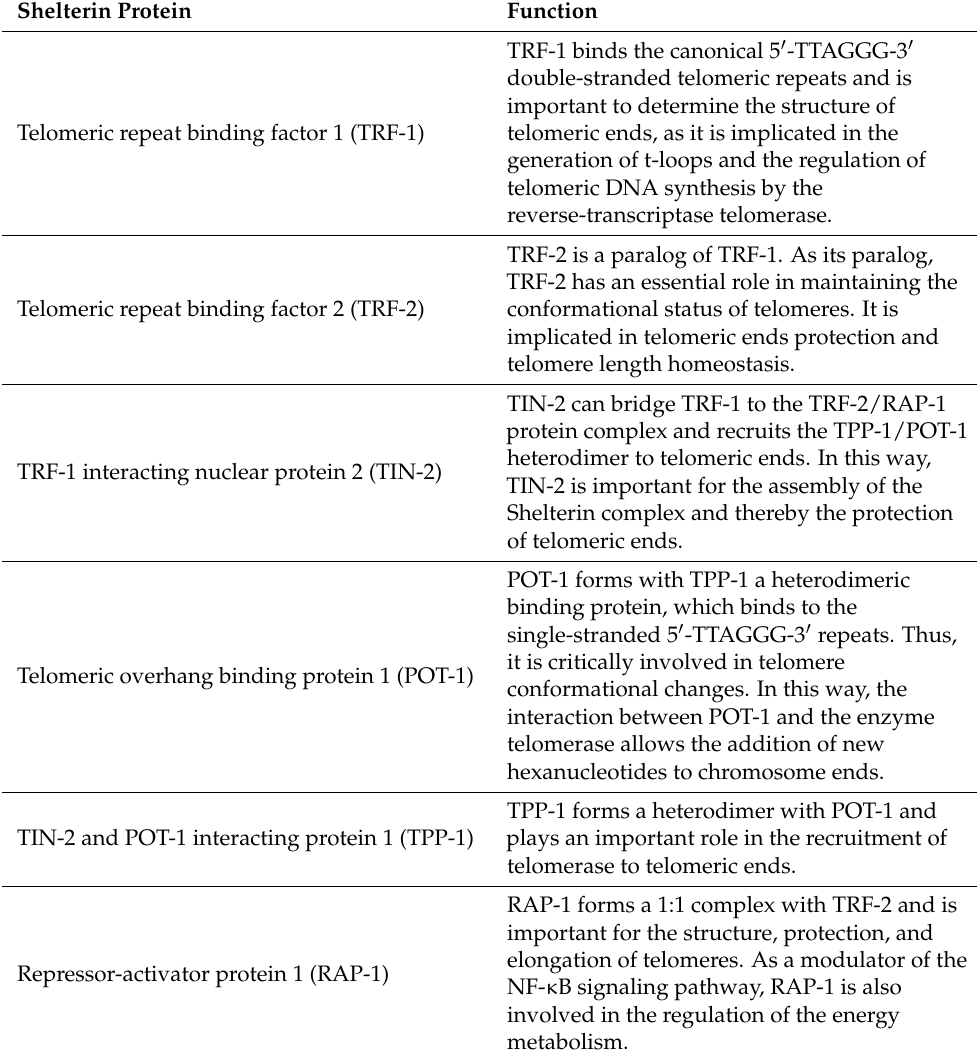
Table 1. Components of the Shelterin complex and their functions.